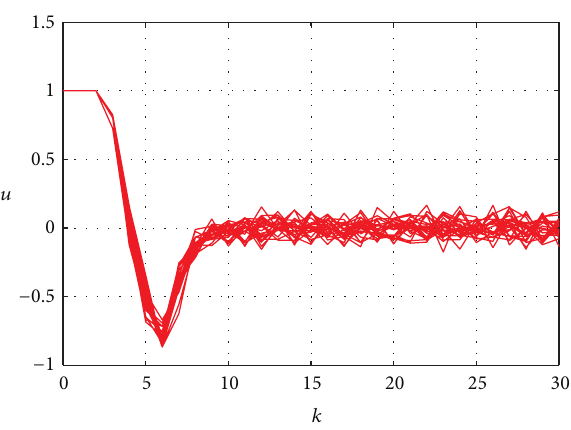
Table 1: Number of